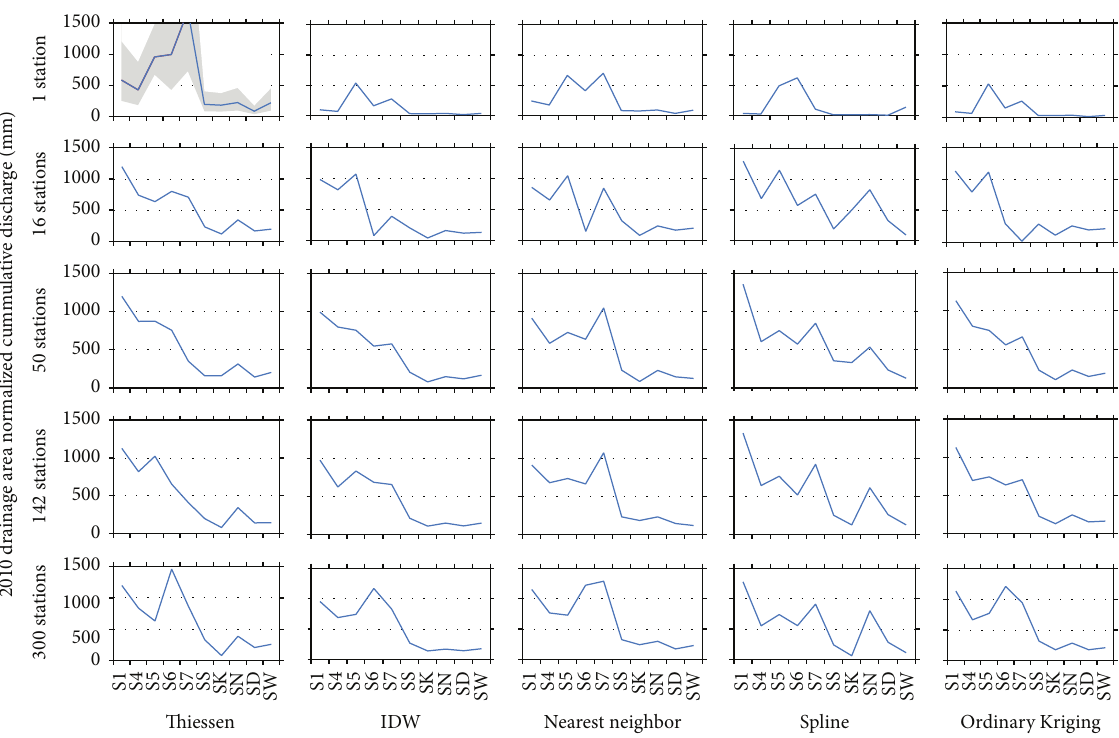
Figure 6: Comparison of 2010 cumulative surface water discharge normalized to the drainage area of monitoring location. The comparison encompasses each of the 5 interpolation methods and the 4 meteorological station distributions. The range in discharge shown in the Thiessen polygon panel for 15 stations assumes a single lumped precipitation value based on the minimum and maximum